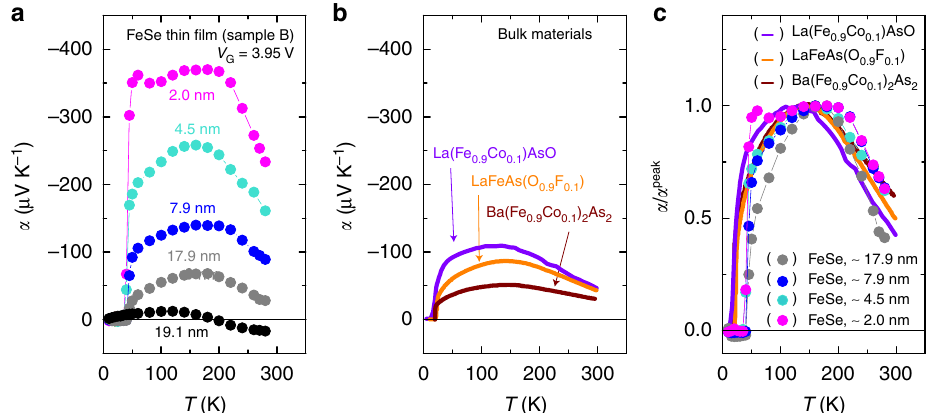
Fig. 4 Temperature dependence of Seebeck coef fi cient. a Seebeck coef fi cient α vs. temperature T in FeSe thin fi lm (Sample B). The values of α were enhanced by the thickness reduction in all temperature regions. b α − T curves in representative Fe-based high- T c superconductors. Ba(Fe 0.9 Co 0.1 ) 2 As 2 27 , LaFeAs(O 0.9 F 0.1 ) 28 , and La(Fe 0.9 Co 0.1 )AsO 29 show the peak behavior at ~150 K, in a similar manner to the FeSe thin fi lm in a . c Temperature dependence of α normalized by the peak value α peak for FeSe thin fi lms and bulk materials in b . Overall temperature variation of α is seemingly common for